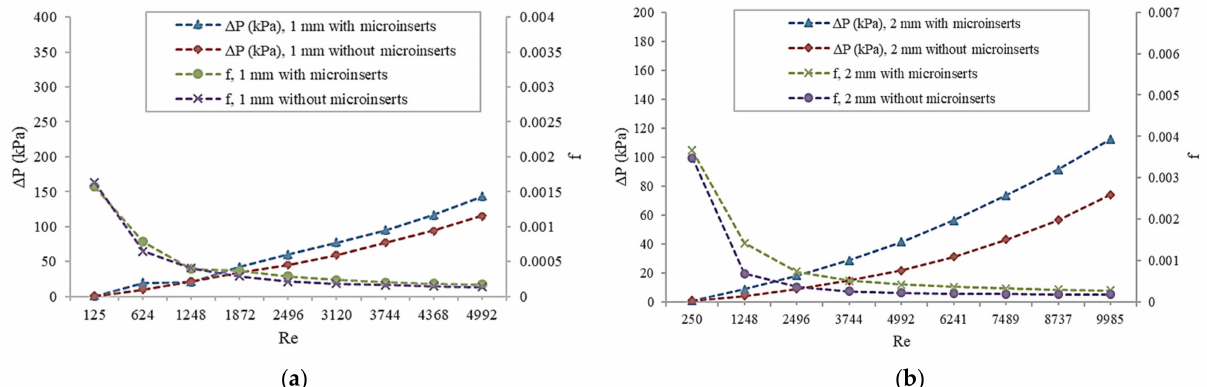
Figure 4. Variation in pressure drop and friction factor against Reynolds number ( a ) for a 1 mm channel and ( b ) for a 2 mm channel.